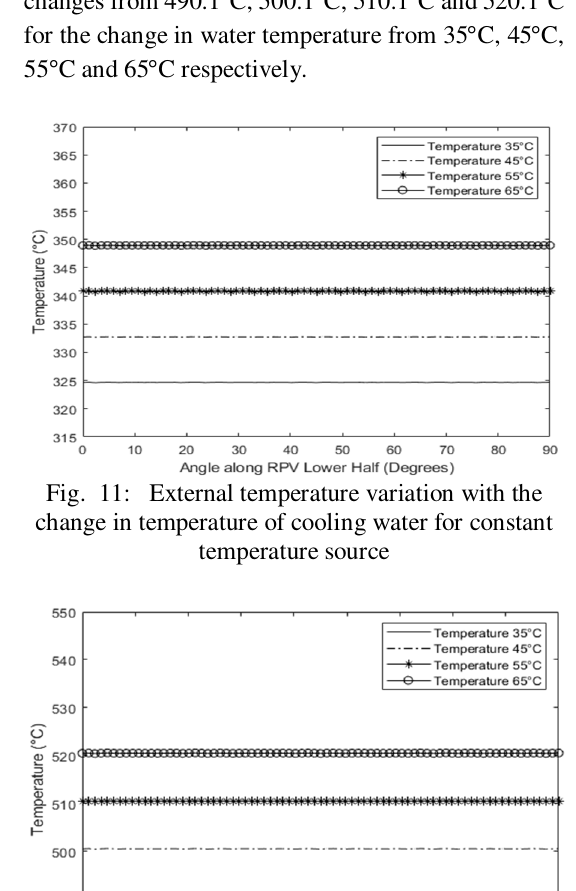
Fig. 10: External temperature variation with the change in thickness of RPV lower plenum for